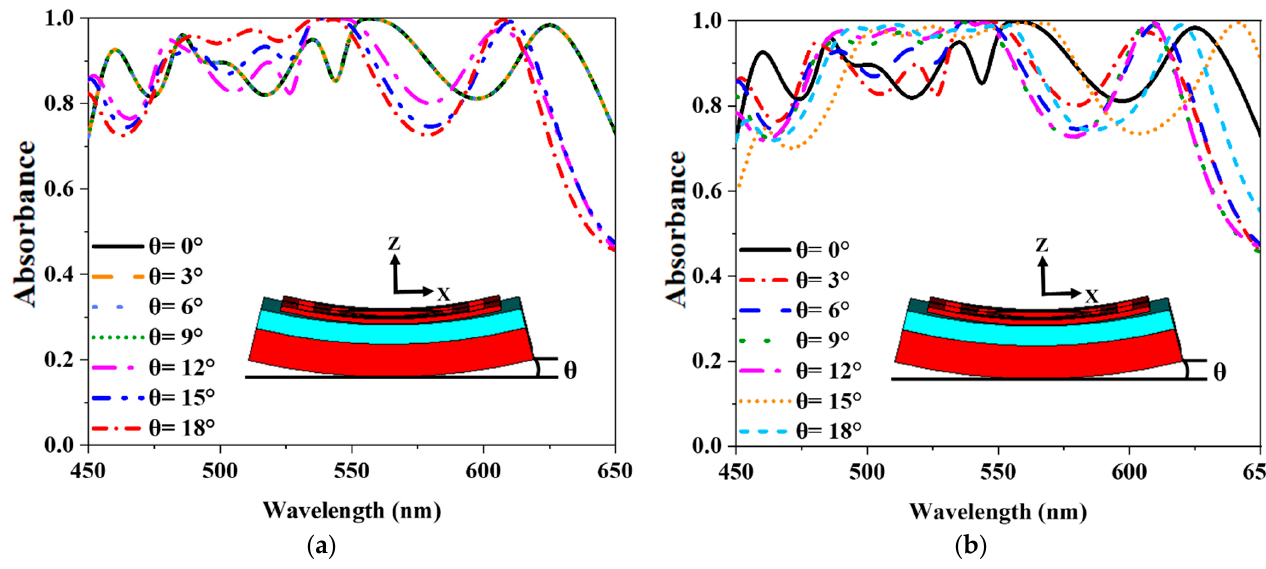
Figure 12. The proposed MMA bending effect ( a ) TE mode ( b ) TM